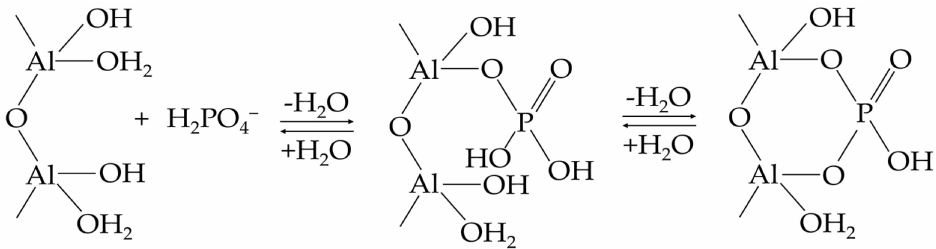
Figure 4. Phosphorus adsorption via ligand exchange on aluminium oxides [47].